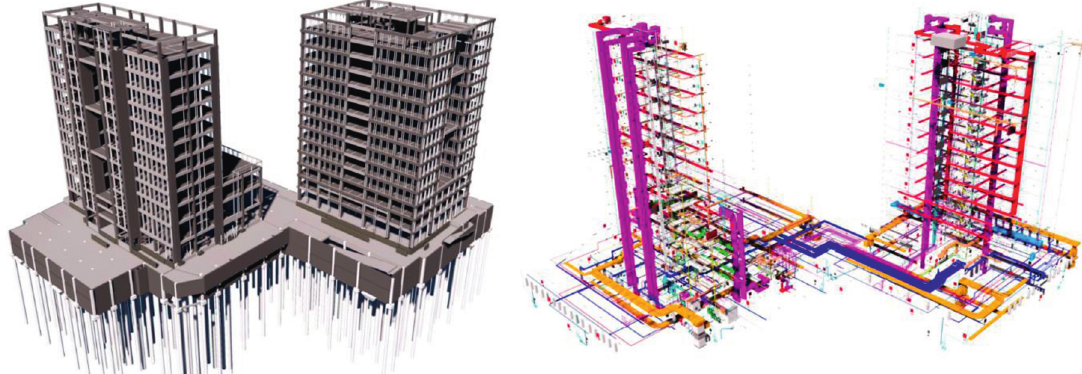
Figure 5: BIM structural, mechanical, electrical, and service